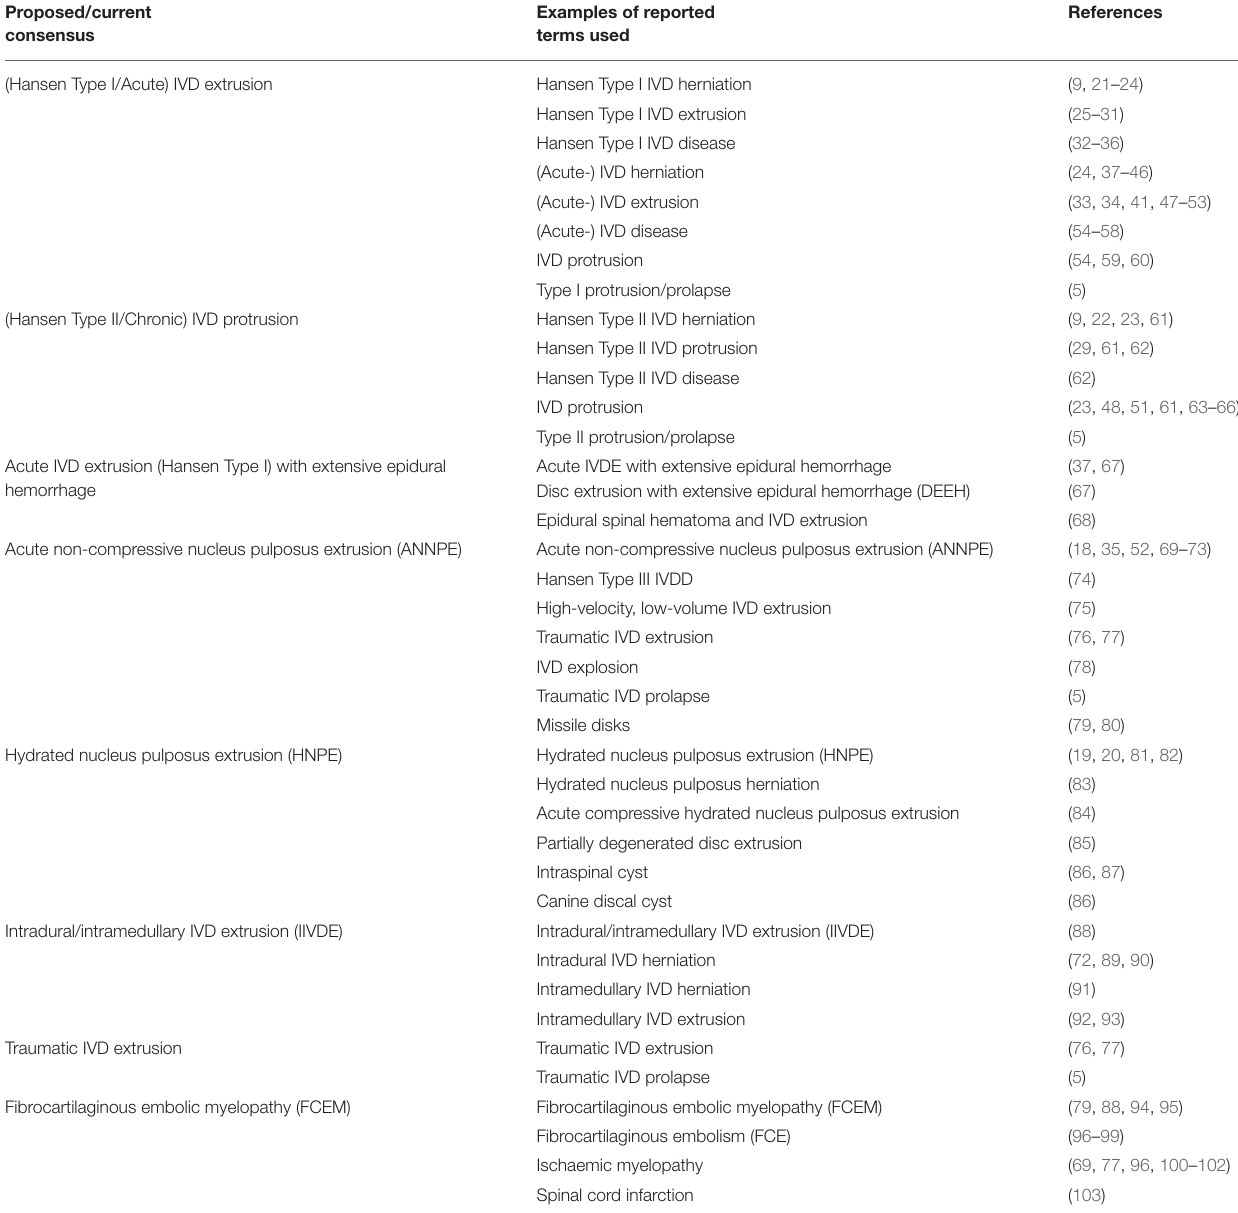
TABLE 2 | Terminology used in the veterinary literature to describe different types of intervertebral disc (IVD) disease. Proposed/current